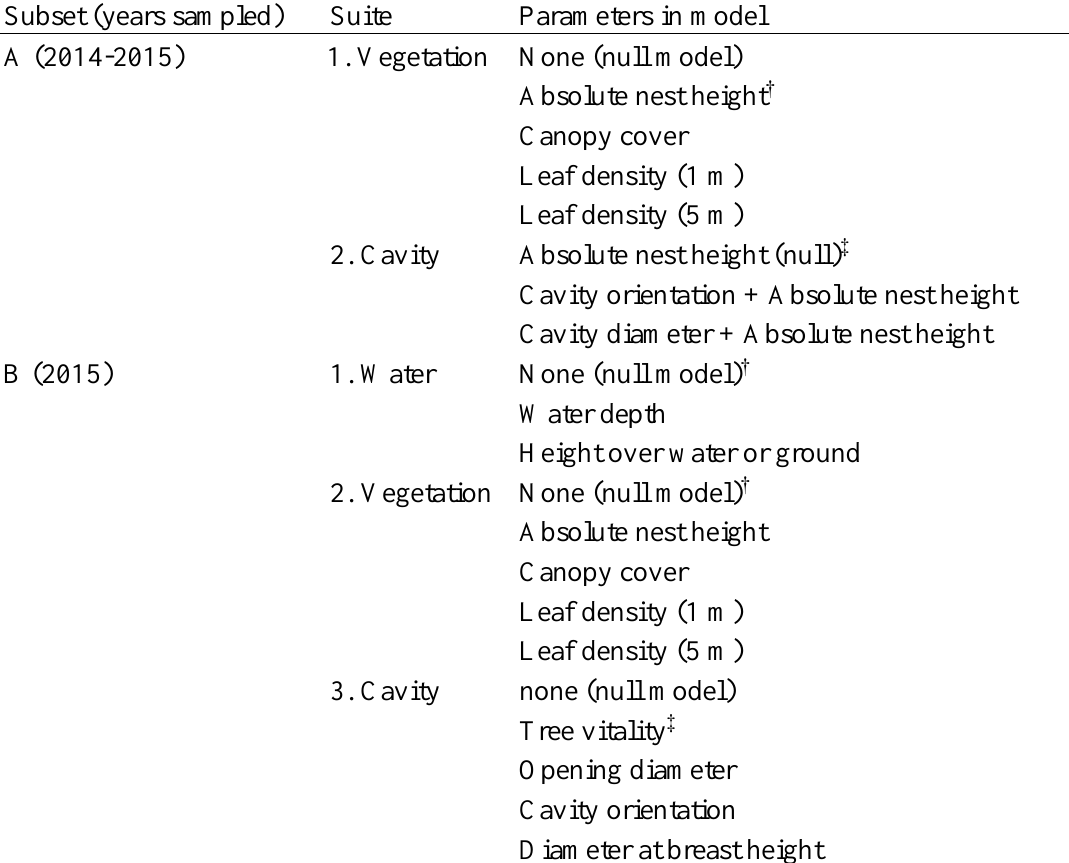
Table A1.1. List of suites built for hierarchical model selection analyzing habitat selection process of Prothonotary Warblers nesting in natural cavities or nest boxes in White River National Wildlife Refuge, Arkansas, USA in 2014-2015. Each model was a generalized linear mixed model with the random effect of territory identity (not shown). The top model of each suite ( † ) was carried on to the next suite as the new suite's null model, and parameters from this model were added to the new suite's models. If no model was better than the null model, the null model was carried on to the next suite. In the text, we report the parameters of the final top model or models ( ‡ ). All models were built and compared in Program